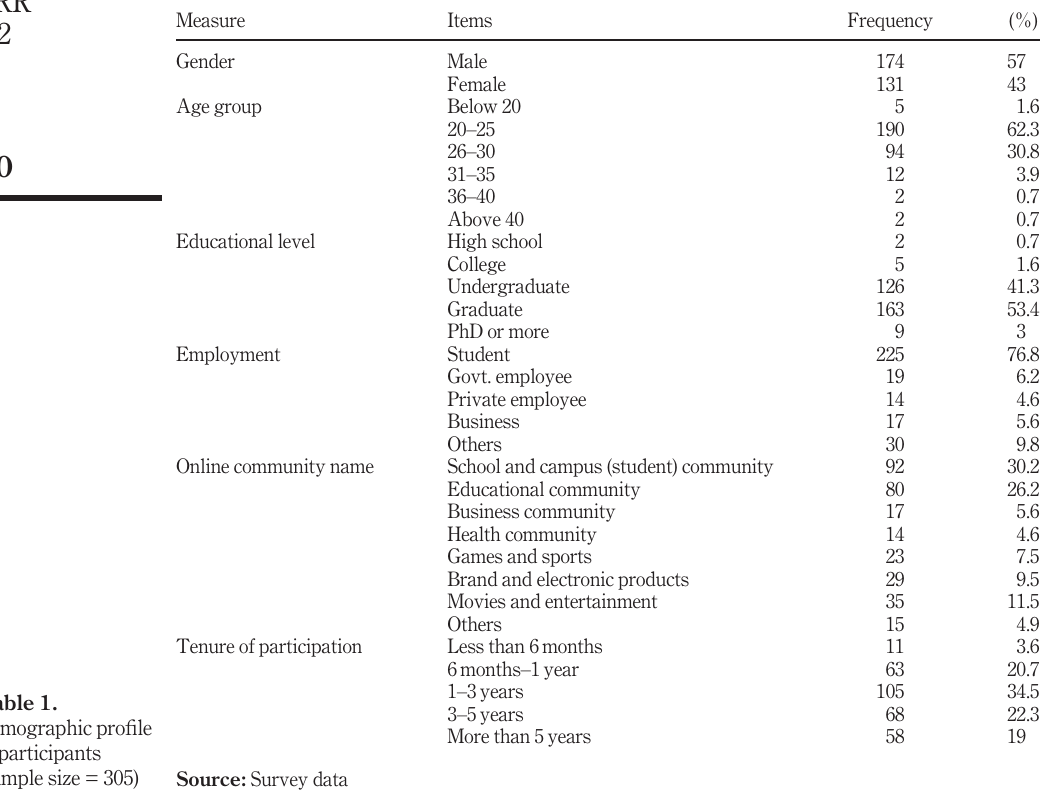
of participants (sample size =